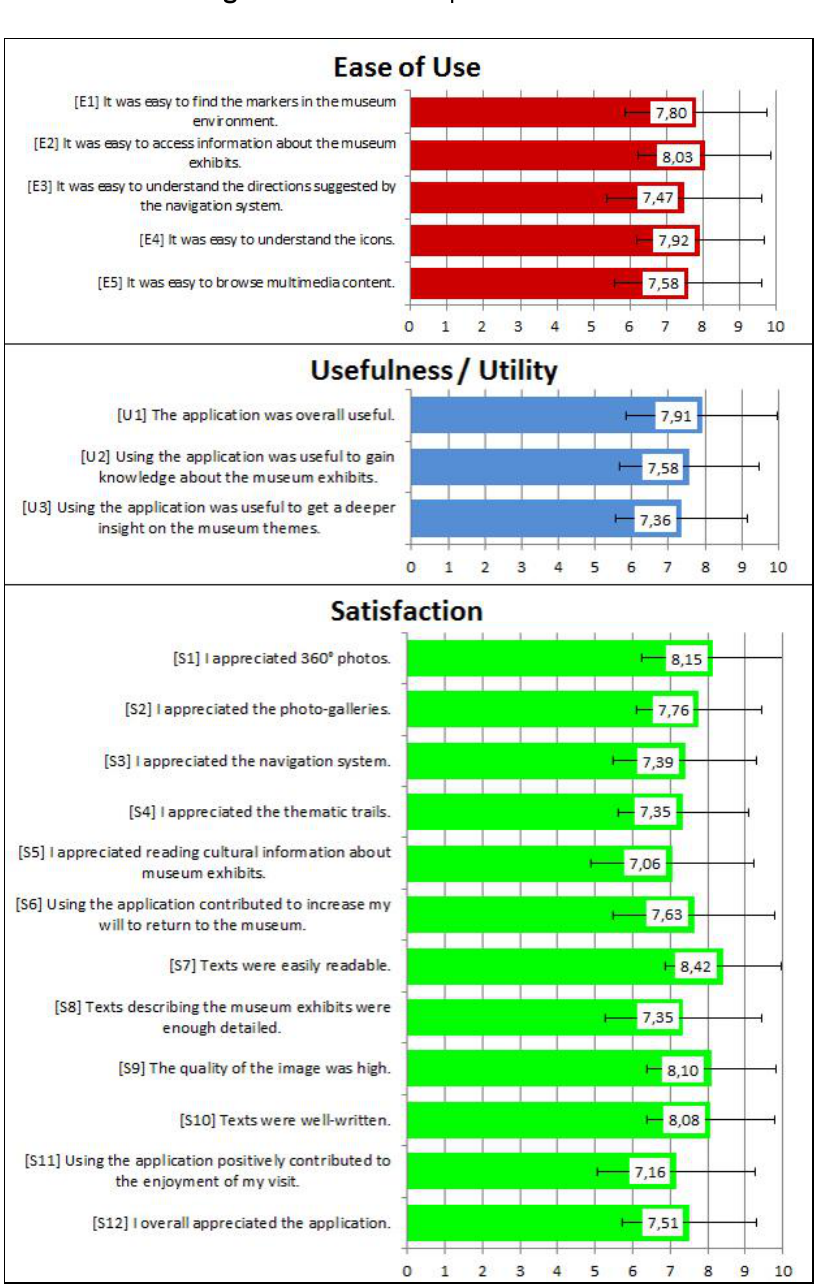
Figure 9. Post-visit